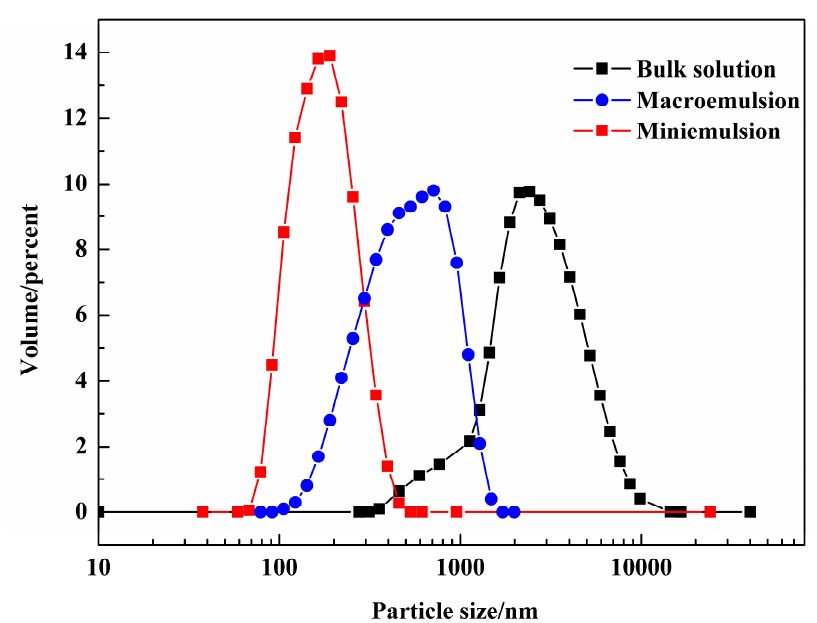
Figure 5. Particle size distributions of PR 146 obtained from the bulk solution, macroemulsion, and miniemulsion.